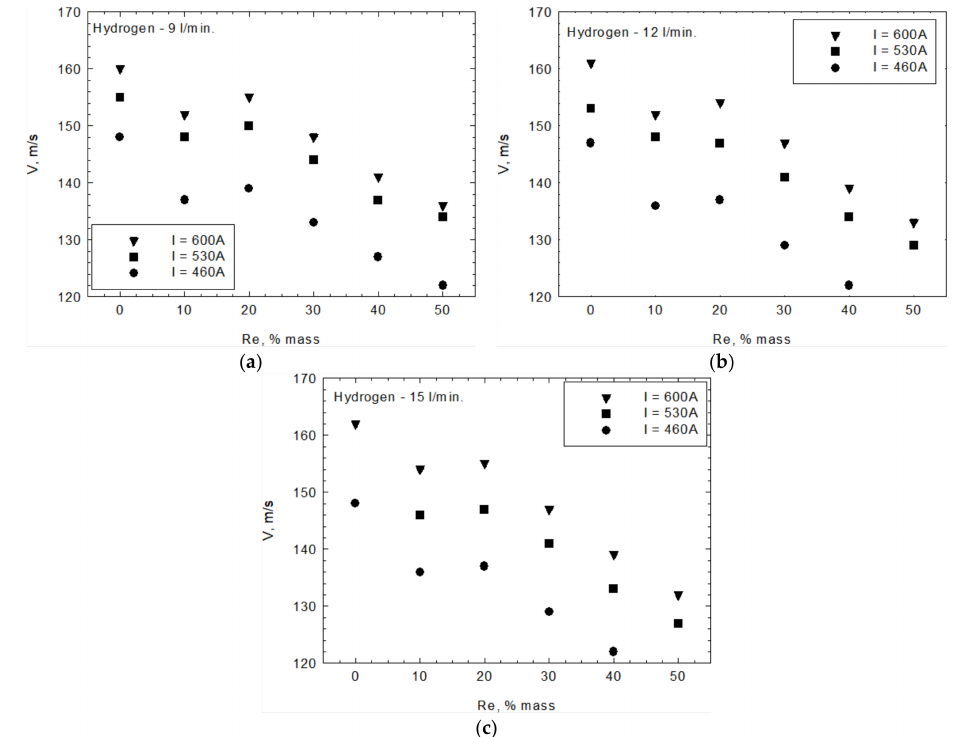
Figure 13. Velocity V of in-flight NiCr + xRe particles measured with current intensity ( a ) I = 460 A, ( b ) I = 530 A, and ( c ) I = 600